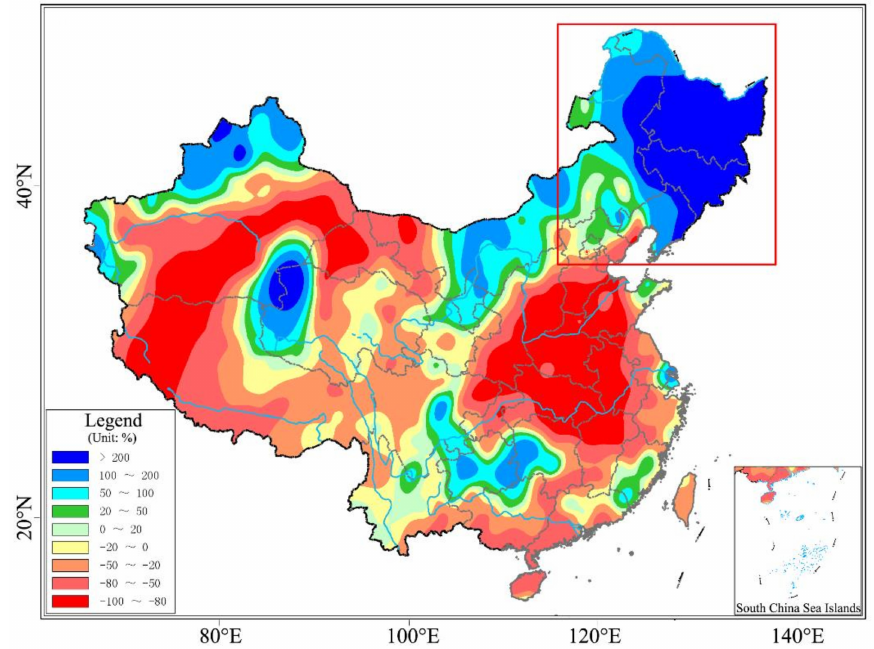
Figure 10. Distribution of the precipitation anomaly percentage in China from 27 August to 7 Septem- ber 2020. The red box marks the region of 118 ◦ –135 ◦ E, 38 ◦ –54 ◦